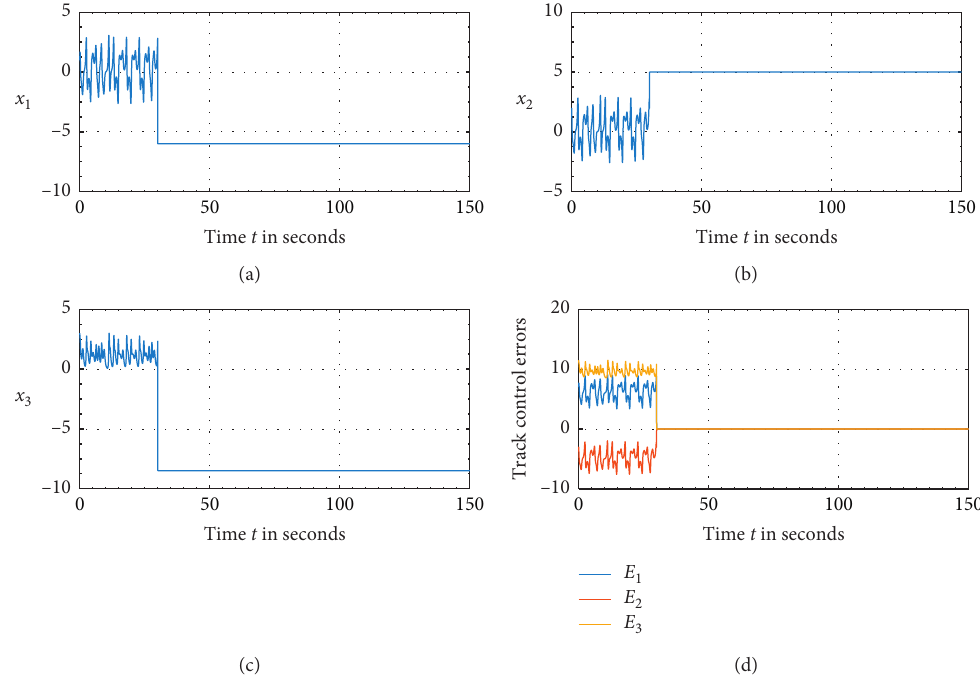
Figure 11: State dynamics under the track control method with reference ( 10 , − 10 , 20 ) and the controller gain k � − 50, where the controller is applied after 30secs. (a) The state variable x and E 3